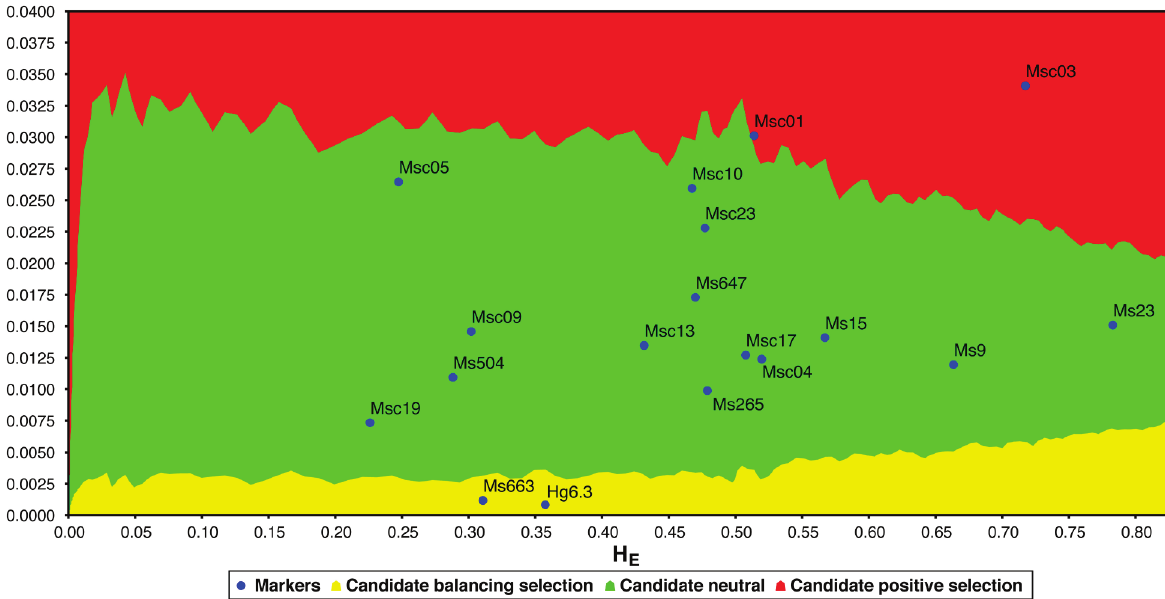
Figure 4. Comparison of F and heterozygosity ( H ) in polymorphic loci to identify ST E outliers and potential candidates for selection using LOSITAN [46]. Loci highlighted in yellow are candidates for balancing selection, whereas loci highlighted in red are candidates for positive selection (loci highlighted in green are selectively